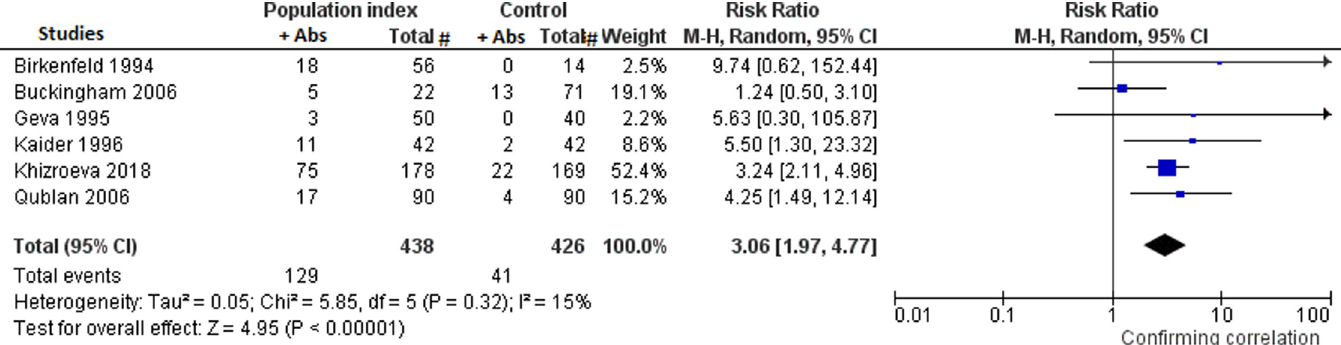
Fig 2. Meta-analyses assessing the risk for implantation failure in relation to the presence or not of anti-PL antibodies in the studies in subgroup A between women with at least two implantation failures in IVF-ET ( population index ) vs . women with one successful IVF-ET ( control ). Fig 2: meta-analysis assessing the risk for implantation failure in relation to the presence or not of any type of anti-PL antibodies.